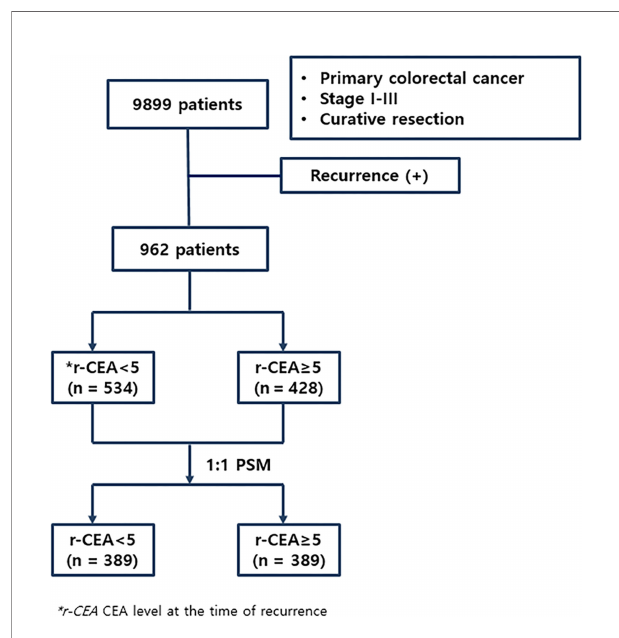
FIGURE 1 | Flowchart of this